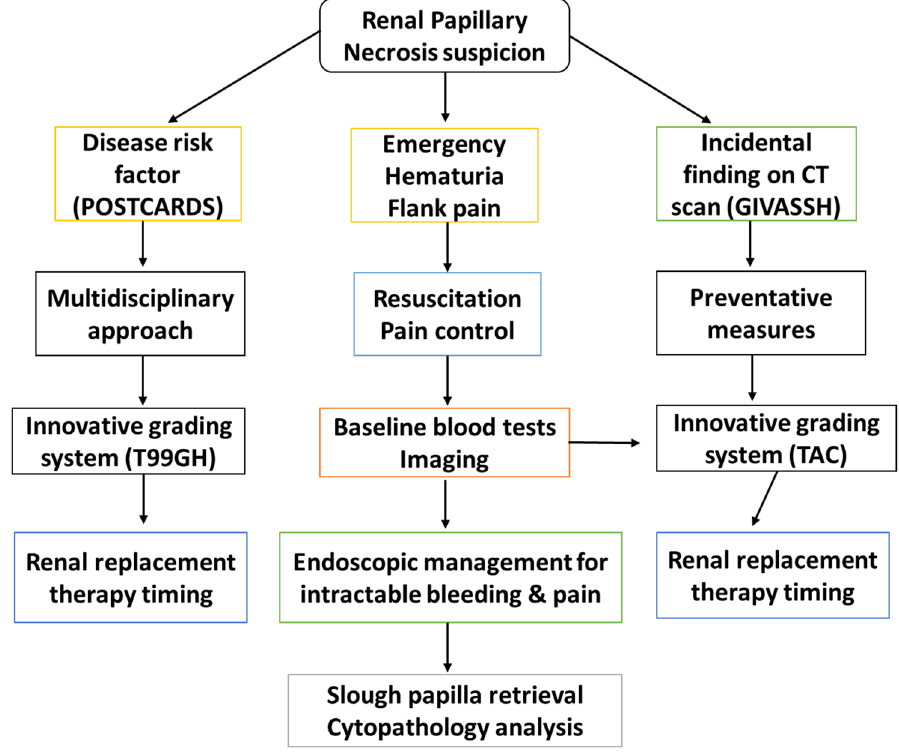
Figure 10. Summary figure depicting RPN proposed algorithm management. Besides identifying risk factors and the role of oxidative stress associated with RPN, it is essential that a multidiscipli ‐ nary approach is considered for early detection of the disease. Integrated management will ensure successful disease outcomes. TAC: total antioxidant capacity; T99GH: technetium 99 glucohepto ‐